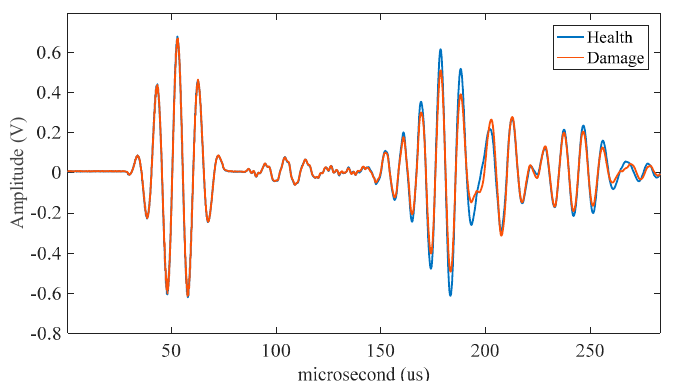
Figure 11. The Lamb wave signals without damage and with damage.